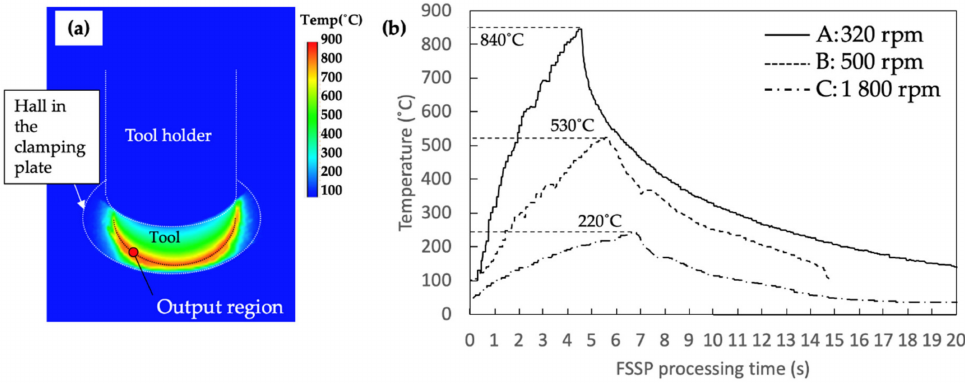
Figure 3. Thermal history measured by IR camera: ( a ) snapshot image of temperature distribution at 4.7 s with process condition C (i.e., the 1800 rpm case); and ( b ) time–temperature curves for each condition measured by IR